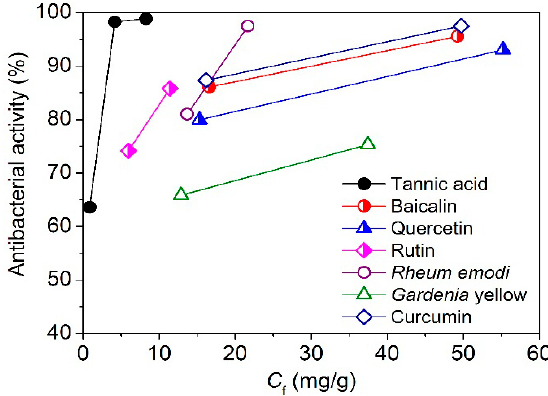
Figure 10. Correlation of the antibacterial activity of the treated silk against E. coli with the adsorption quantity of natural compounds on silk.